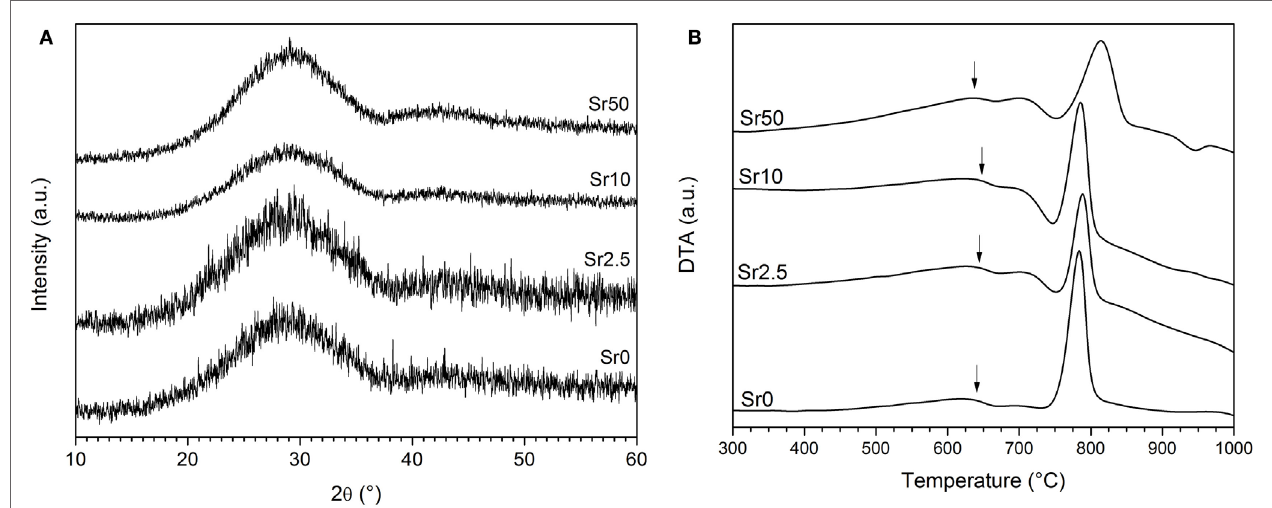
FigUre 1 | (a) XRD patterns of the glasses, showing the typical amorphous halo. (B) DTA traces of the glasses, showing glass transition temperatures ( T g ) highlighted by arrows and crystallization